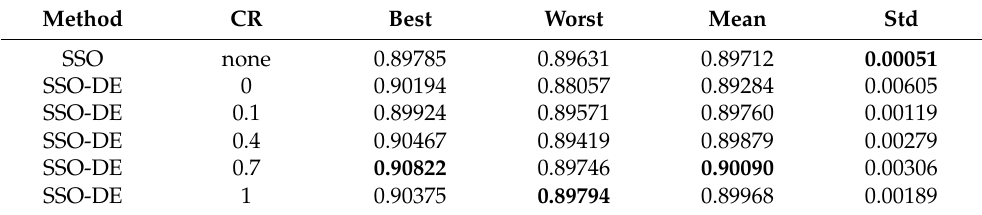
Table 17. Parameter settings for SSO-DE.